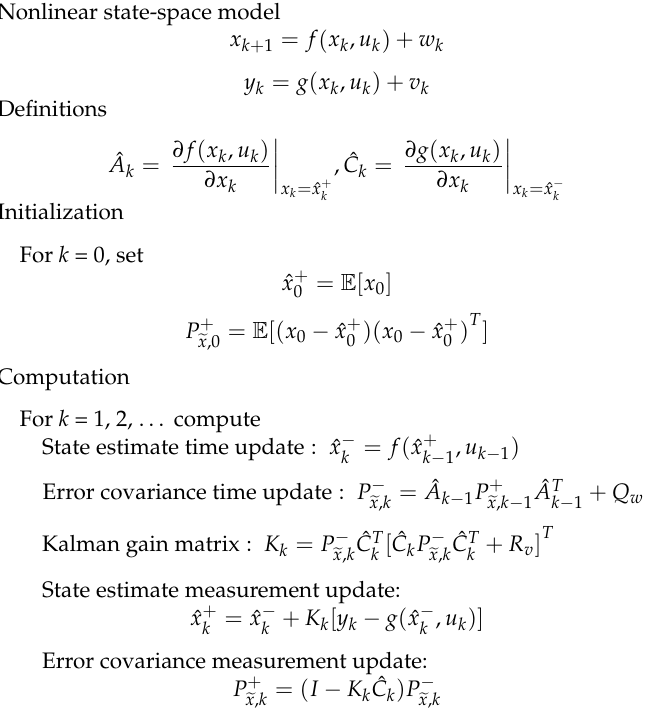
Table 3. Summary of the extended Kalman filter algorithm